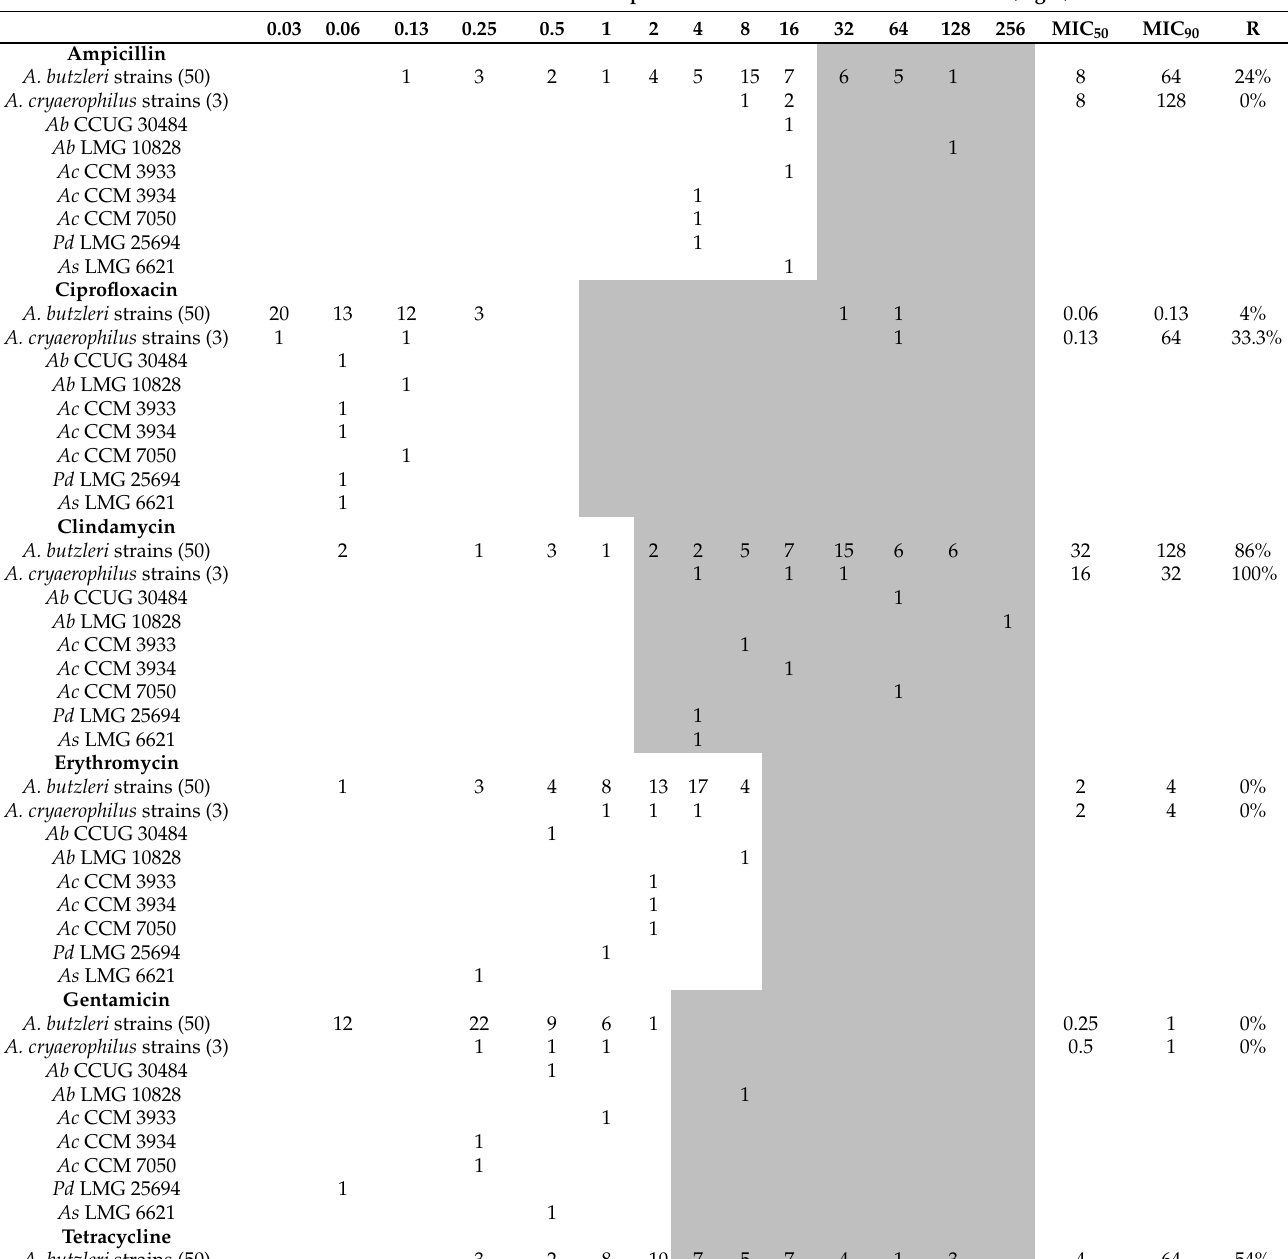
Table 1. Minimum inhibitory concentration (MIC) and identical minimum bactericidal concentration (MBC) data on antibiotic agents determined for 60 Arcobacter -like strains isolated within the Czech Republic and collection strains. Number of Isolates Susceptible at Given Concentrations and MICs